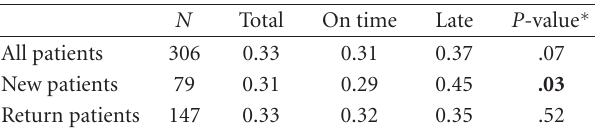
Table 4: Exam room utilization ( P -values determined by indepen- dent t -test). N Total On time Late